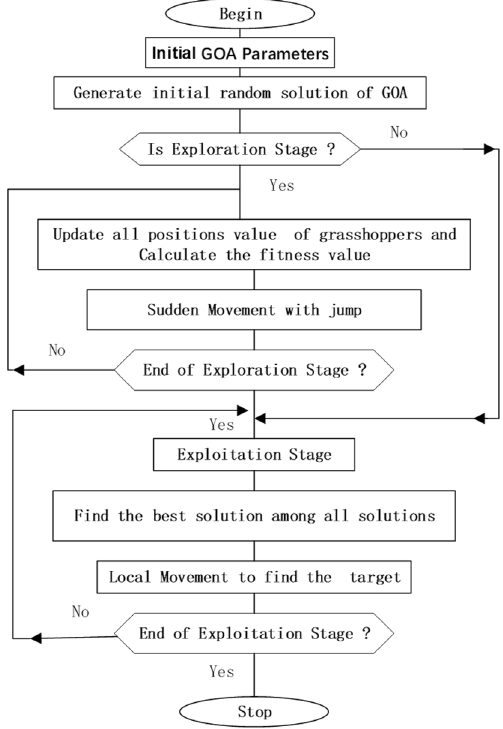
Figure 1. The grasshopper swarm searches with two